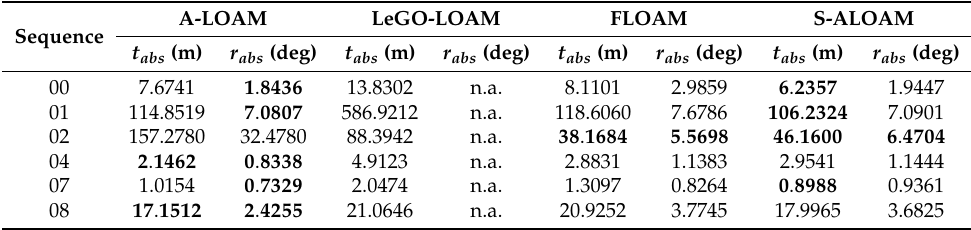
Figure 7. The real image in the KITTI dataset. Table 2. The absolute errors of the proposed method (S-ALOAM) compared with A-LOAM, LeGO- LOAM and FLOAM, where t abs represents the root-mean-square error (RMSE) of translations, while r abs represents rotation error. n.a. in this table indicates the rotation part of LeGO-LOAM is not available. Bold indicates the best